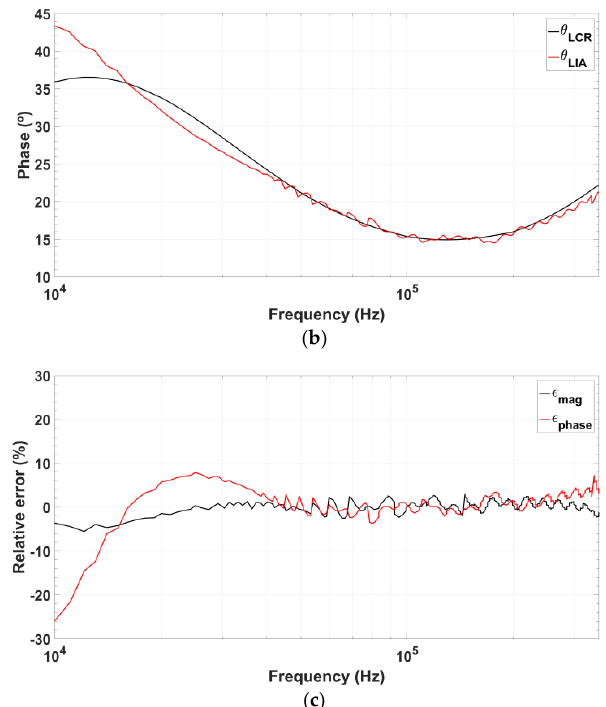
Figure 16. Comparison of the impedance values measured using the signals from the proposed quadrature oscillator prototype (red) and those obtained using the commercial 8101G LCR-meter (black) for impedance values measured in protein detection: ( a ) Recovered impedance magnitude; ( b ) Recovered impedance phase, and ( c ) Relative error of both magnitude and phase.